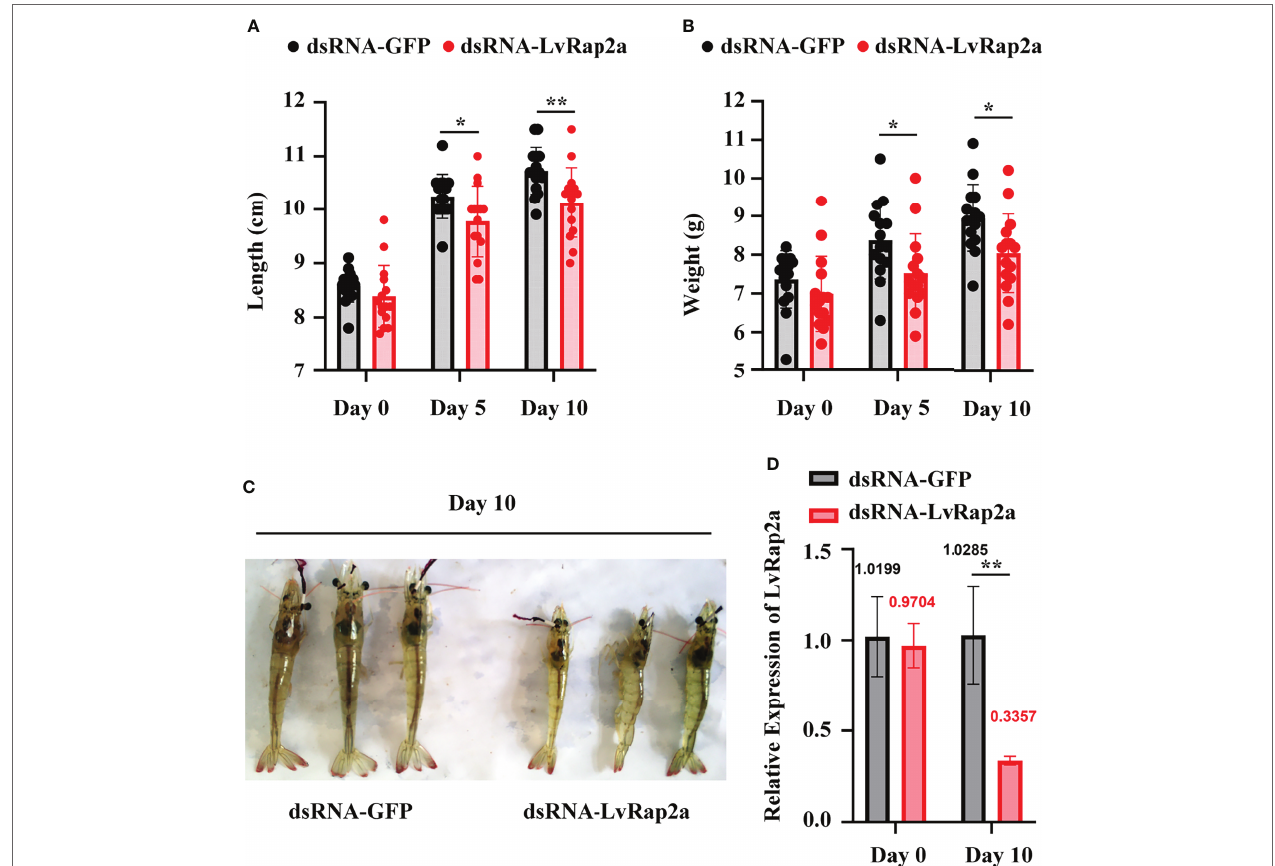
FIGURE 4 | Roles of LvRap2a on the growth traits of shrimp. (A) Length of shrimp on day 0, day 5 and day 10 post dsRNA injection. The data were provided as the means ± SD of 15 shrimp. (B) Weight of shrimp on day 0, day 5 and day 10 post dsRNA injection. The data were provided as the means ± SD of 15 shrimp. (C) Gross signs of shrimp on day 10 post dsRNA treatment. (D) Quantitative PCR analysis of the silencing efficiency of LvRap2a. Asterisks indicate significant differences ( *p < 0.05 and **p < 0.01). All the experiments were performed two times with identical